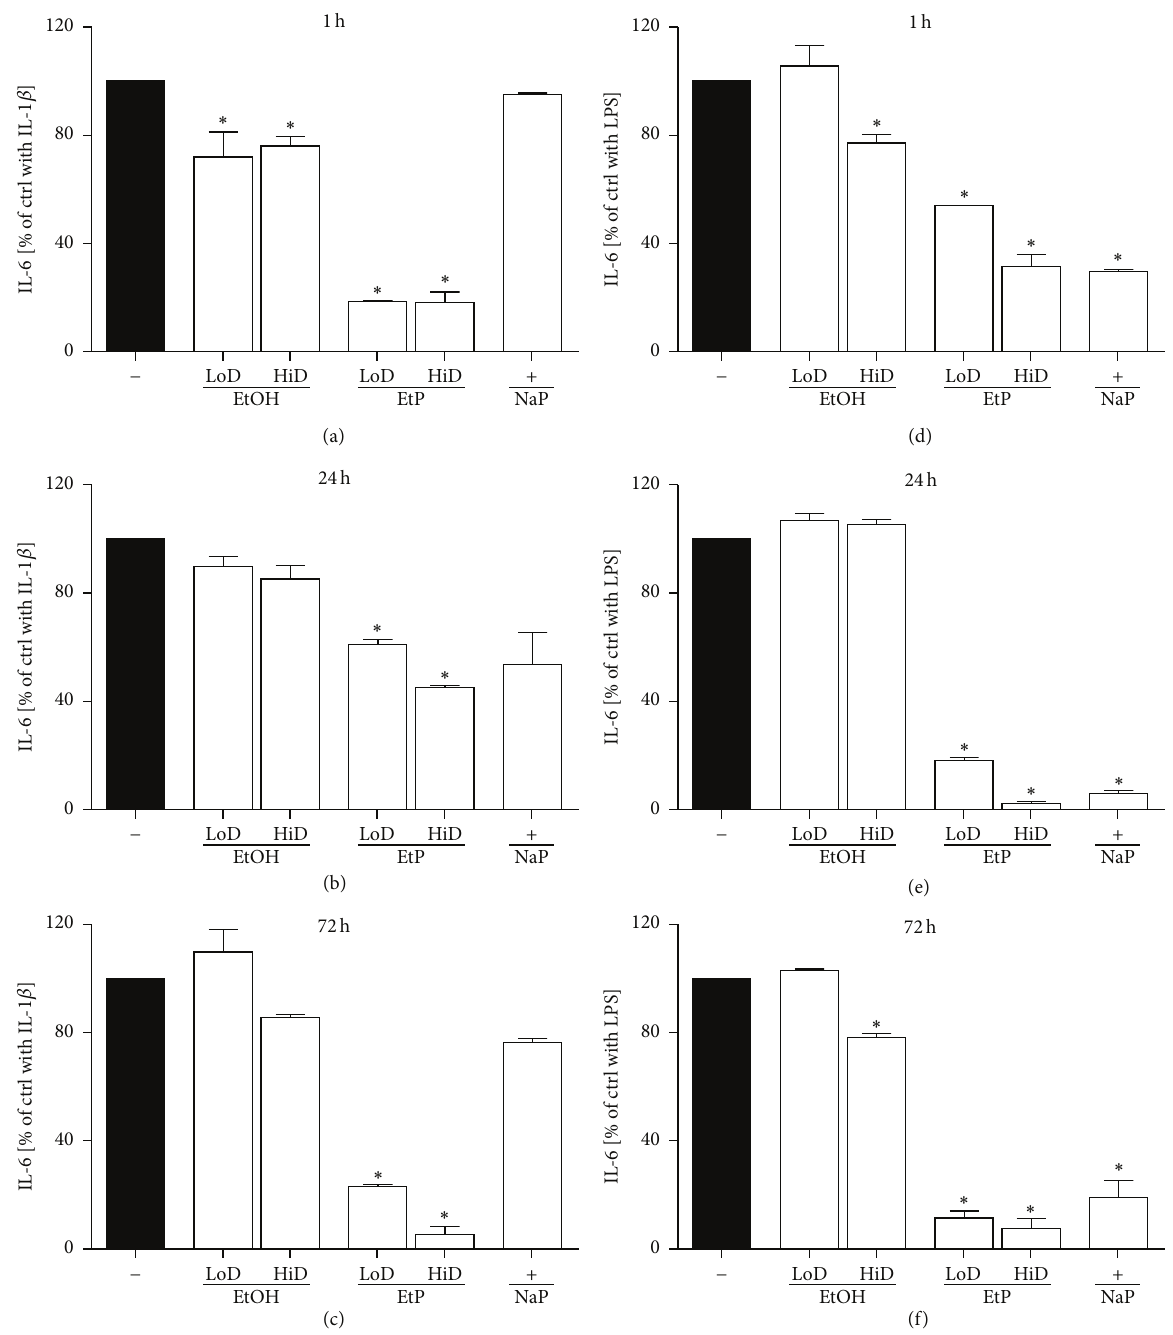
Figure 6: Effects of ethanol (EtOH), ethyl pyruvate (EtP), or sodium pyruvate (NaP) on interleukin (IL)-6 release from lung epithelial cells A549 after IL-1beta ((a)–(c)) or lipopolysaccharide (LPS (d)–(f)) stimulation. Cells were treated with EtOH (low dose, LoD = 85 mM and high dose, HiD = 170mM), EtP (LoD = 2.5 mM, HiD = 10mM), or NaP (10mM) for 1 h ((a) and (d)), 24h ((b) and (e)), or 72 h ((c) and (f)) and then stimulated with IL-1beta (1ng/mL) or LPS (1 𝜇 g/mL) for 24 h. After the incubation periods, supernatants were analyzed for IL-6 concentrations (given as % of cells stimulated with agonists only, control, ctrl). The data are presented as means ± s.e.m. ∗ 𝑃 < 0.05 versus ctrl.